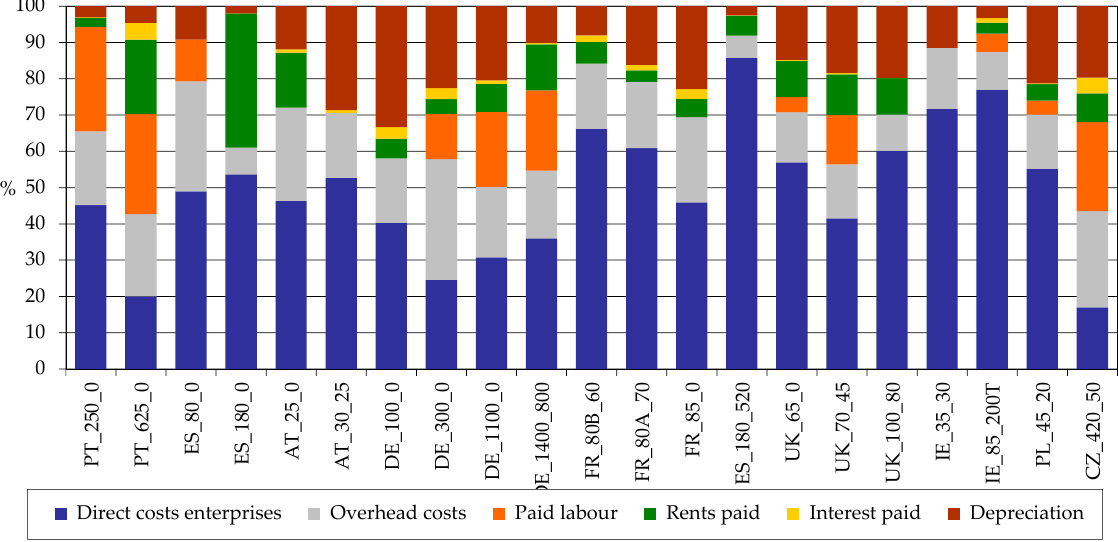
Figure 13. Whole farm costs—% values. Source: model results.